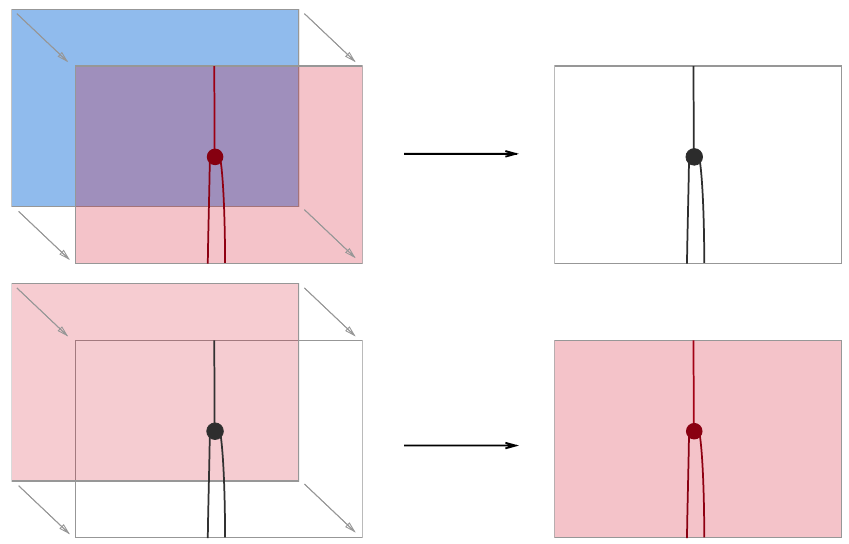
Figure 2 . Top: a collection of defects of various codimension in an invertible system can be mapped to a lower dimensional stand-alone system by stacking with an inverse system and deforming the bulk to a trivial system. Bottom: lower dimensional systems can be stacked on top of a system to create simple defects. The two operations are essentially inverse of each other, up to important ambiguities in the choice of how to deform the bulk to a trivial system.